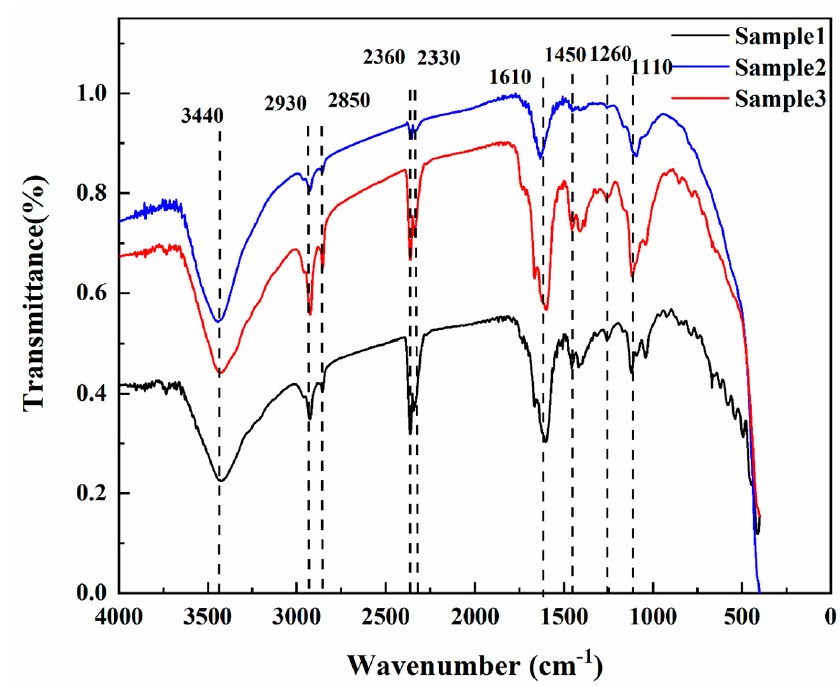
Figure 4. FTIR spectra of the three fluorite samples.